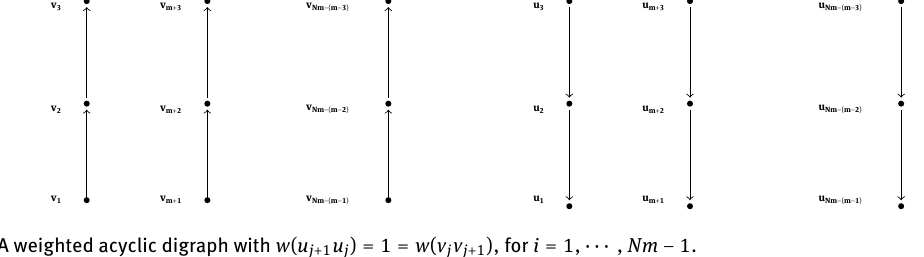
Figure 3: A weighted acyclic digraph with w ( u j +1 u j ) = 1 = w ( v j v j +1 ), for i = 1, ··· , Nm − 1.